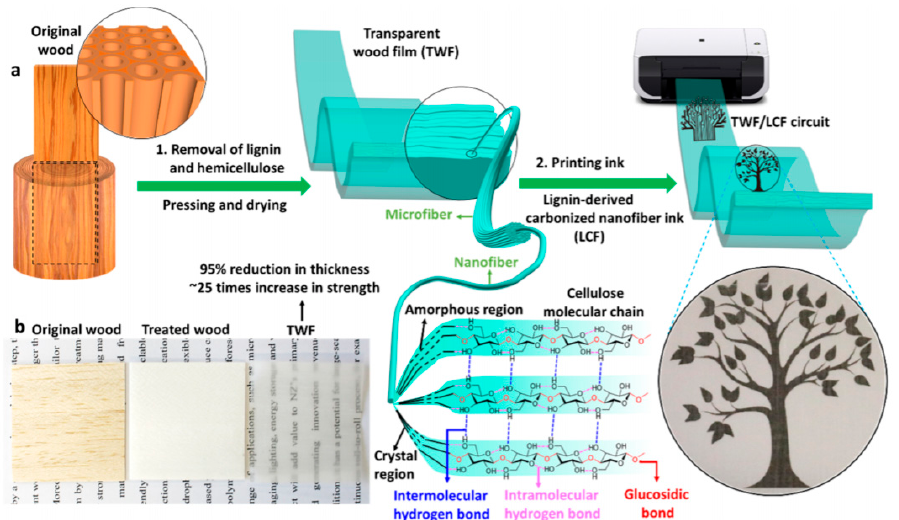
Figure 3. Processing of wood to make films for flexible electronics. ( a ) Lignin and half the of hemicellulose are removed from the wood, then pressed and dried under ambient conditions. Under these conditions, the chemical structure consists of cellulose microfiber bundles, nanofibrils, and cellulose chains with both crystalline and amorphous regions. Ink is also derived from wood, more